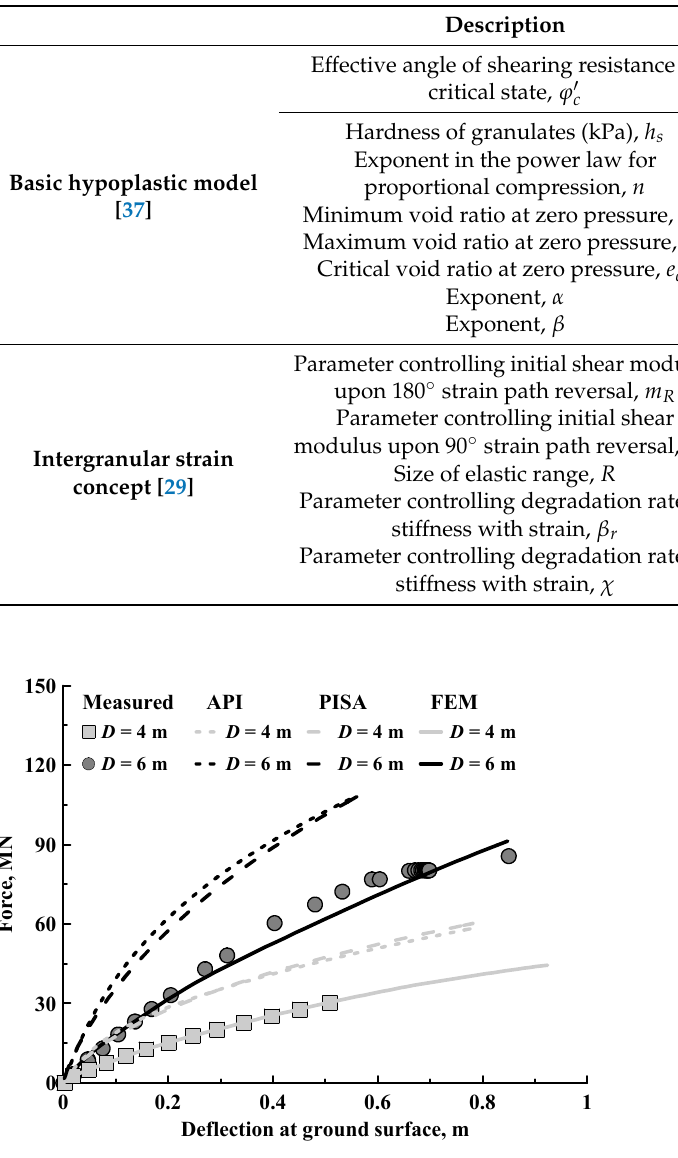
Figure 4. Comparison of measure and computed load-deflection response of centrifuge tests.